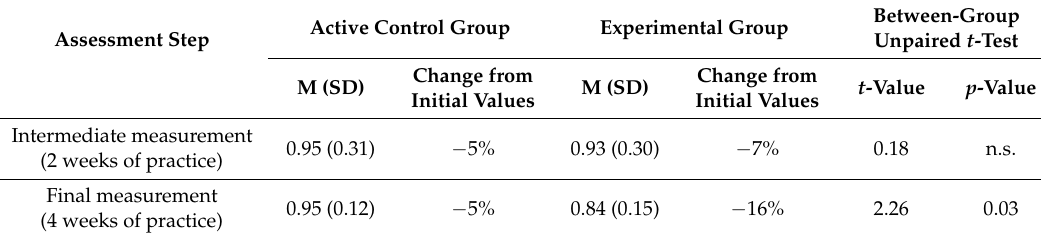
Figure 3. Modulation of perceived stress levels as measured by the Perceived Stress Scale (PSS-10) questionnaire (percentage changes weighted on individual baseline level of stress). Bars mirror mean changes of perceived stress for the Control (blue) and Experimental (red) groups, halfway through the interventions (t1) and at the end of the intervention (t2). Error-bars represent 1 SE. Table 2. Group means, standard deviations, change scores, and data on between-group statistical comparisons of the modulation of the PSS-10 scores for the active control and the experimental groups. PSS-10: Perceived Stress